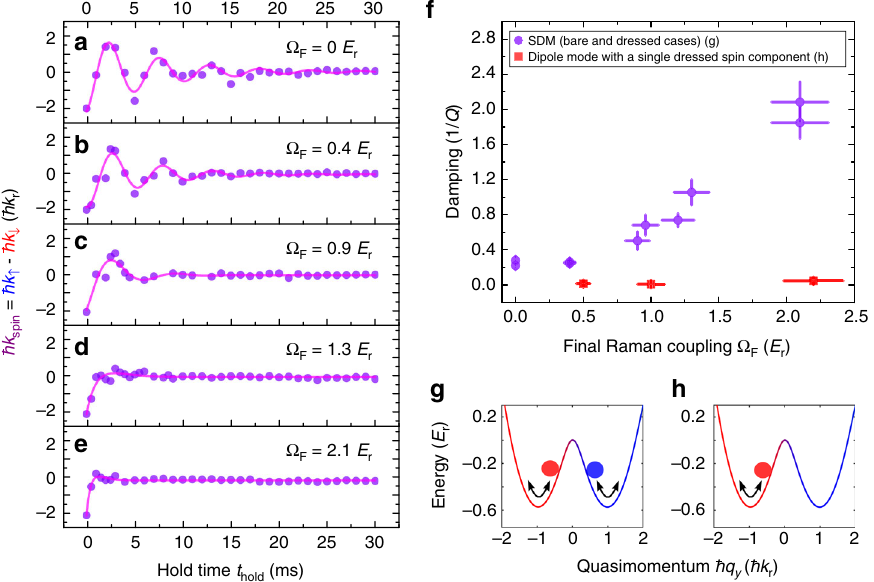
Fig. 3 Momentum damping at different Ω F , for SDM and the dipole mode of a single dressed spin component. a – e Relative momentum oscillations in SDM, ħ k Ω fi tted to a damped sinusoidal function (line) to extract the inverse quality spin , as a function of t hold at various F . The experimental data (scatters) are factor 1/ Q of the oscillations. f Momentum damping (quanti fi ed by 1/ Q ) versus Ω F . The error bar of 1/ Q is the standard error of the fi t. The purple circle data correspond to the SDM (illustrated by g ) and the red square data correspond to the dipole mode of a BEC with a single dressed spin component prepared in # ′ j i (illustrated by h ). In g , h , the representative band structure is calculated at Ω = 1.0 E